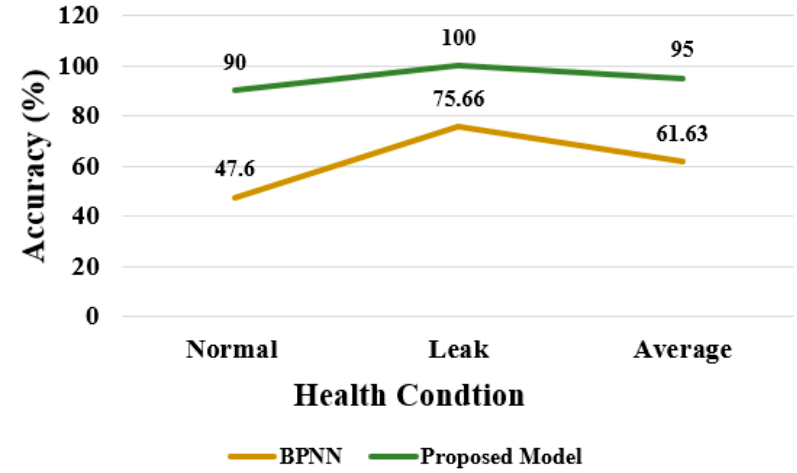
Figure 10. Classification accuracy comparison of the proposed spherical tank leakage detection model with a back propagation neural network.